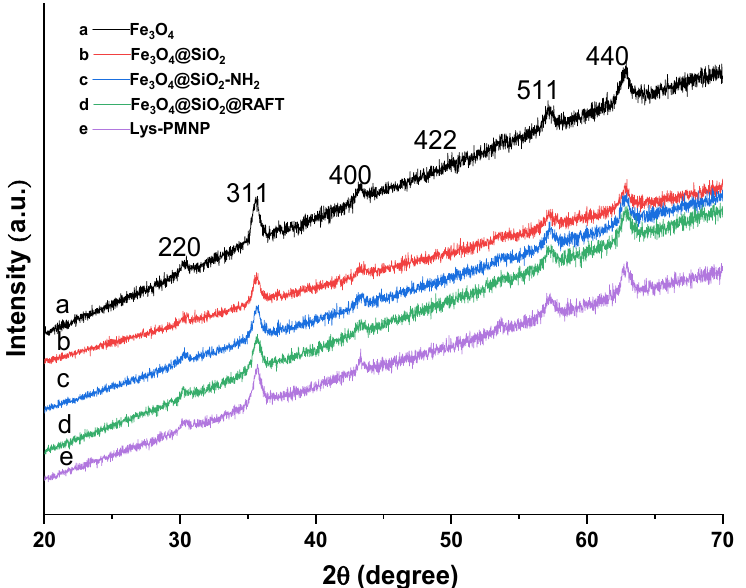
Figure 1. X-ray diffraction spectra of Fe 3 O 4 ( a ), Fe 3 O 4 @SiO 2 ( b ), Fe 3 O 4 @SiO 2 -NH 2 ( c ), Fe 3 O 4 @SiO 2 @RAFT ( d ) and Lys-PMNP ( e ).